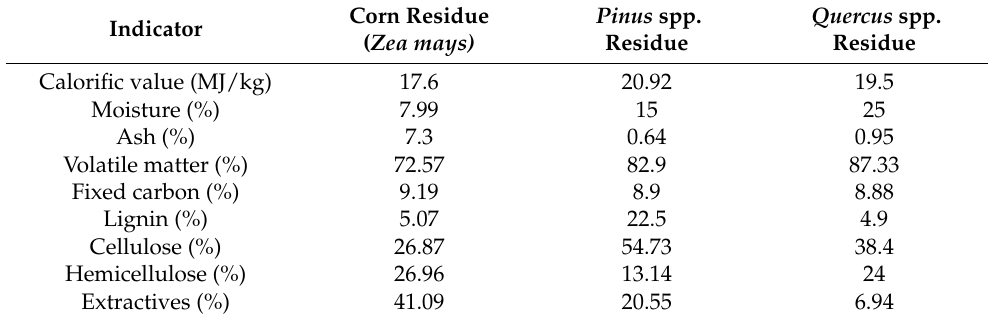
Table 5. Evaluation of the